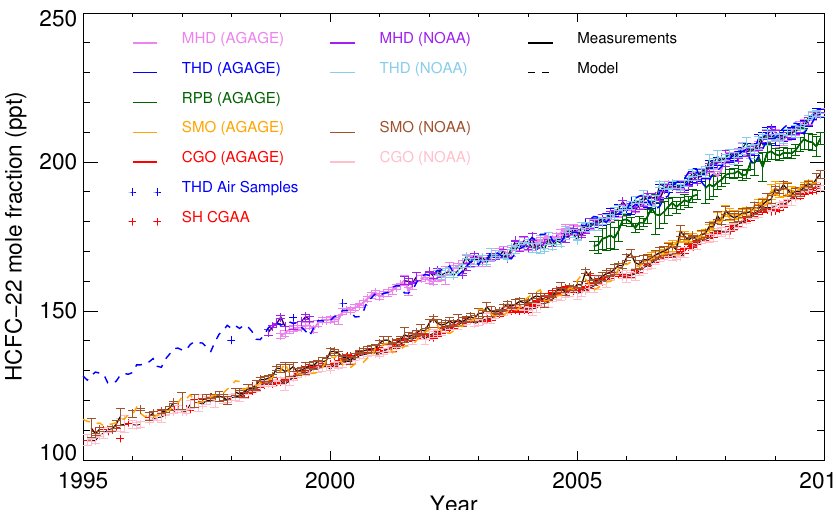
Fig. 2. Global AGAGE and NOAA HCFC-22 observations. AGAGE archived air samples at Cape Grim, Tasmania (CG air archive, red crosses) and air samples at Trinidad Head, California (THD air samples, blue crosses). AGAGE in situ and NOAA flask measurements filtered for background at Cape Grim, Tasmania (CGO, red for AGAGE and pink for NOAA), Cape Matatula, Samoa (SMO, orange for AGAGE and brown for NOAA), Ragged Point, Barbados (RPB, green for AGAGE), Trinidad Head, California (THD, blue for AGAGE and sky blue for NOAA), and Mace Head, Ireland (MHD, violet for AGAGE and purple for NOAA). Atmospheric mole fractions predicted by MOZART using optimized emission estimates are shown in dashed lines for Cape Matatula, Samoa (brown) and Trinidad Head, California (blue). 33